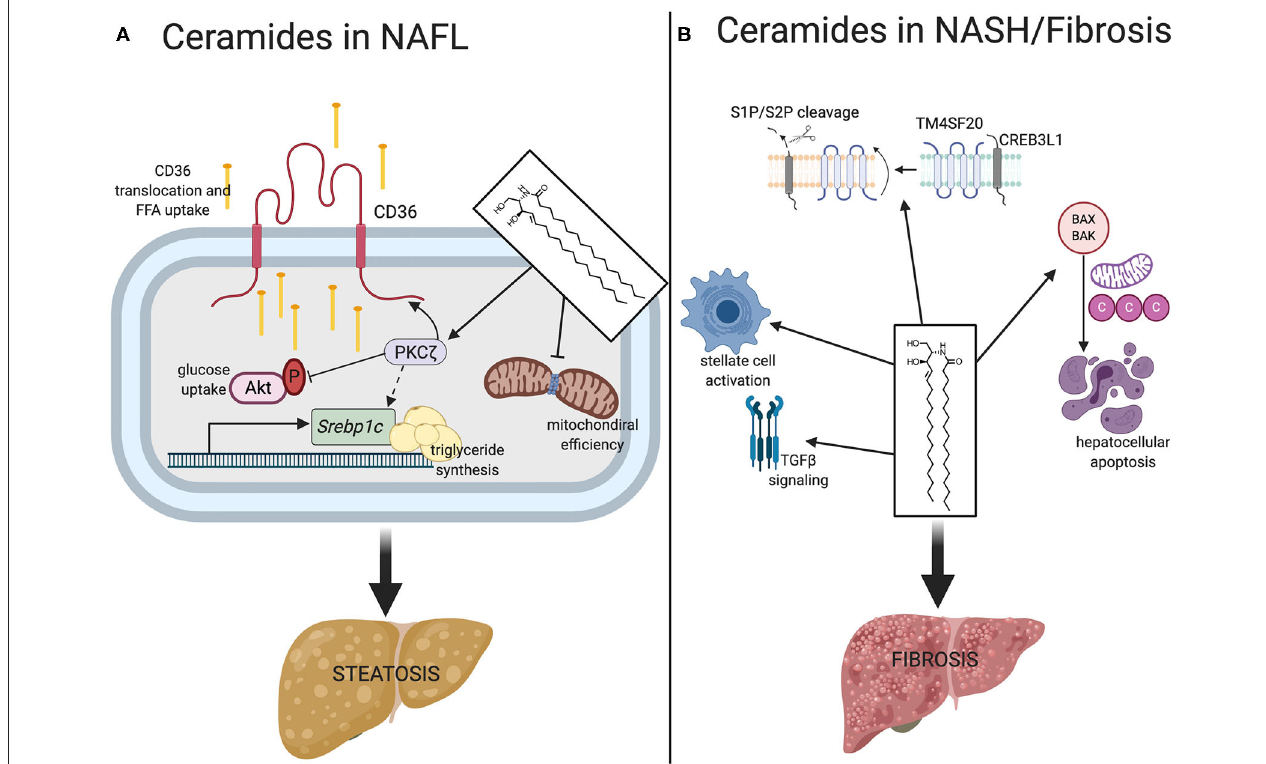
FIGURE 1 | Mechanisms of ceramides contribute to NALF and NASH/fibrosis. (A) In NAFL, ceramides promote lipid accumulation ultimately resulting in hepatosteatosis. In promoting steatosis, ceramides stimulate the translocation of CD36 to its active site on the plasma membrane via obligate intermediate PKC ζ where it facilitates uptake and esterification of free fatty acids. Ceramide action on PKC ζ also upregulates transcription of Srebpc1 and inhibits Akt. Ceramides also reduce mitochondrial efficiency, promoting fat as a preferred substrate. (B) Ceramides promote fibrosis through TGF- β signaling, CREB3L1 proteolysis, stellate cell activation, and hepatocellular apoptosis. Srebpc1 , sterol regulatory element binding protein 1; S1P/S2P, site 1 protease, site 2 protease; TM4SF20, transmembrane 4 super family 20; CREB3L1, CAMP responsive element binding protein 3. Figure was created with